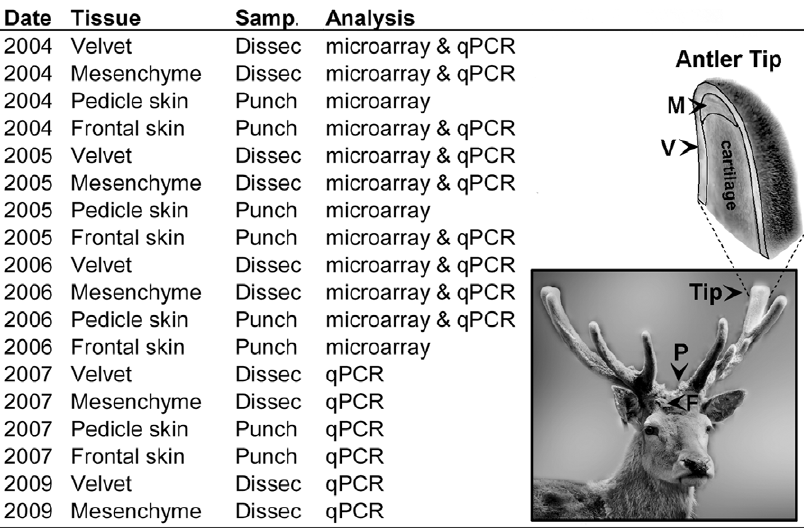
Figure 1. Samples employed in the study. For every sample, the table details its code, year of sampling, type of tissue sampled, sampling method, and the analyses in which it was used. The associated photographs show the sampling areas V: Velvet; M: Mesenchyme; P: Pedicle skin and F: Frontal skin. Punch samples were obtained using a biopsy punch while Dissec ones were obtained after dissection of the antler tissues. qPCR corresponds to quantitative real-time PCR analysis.